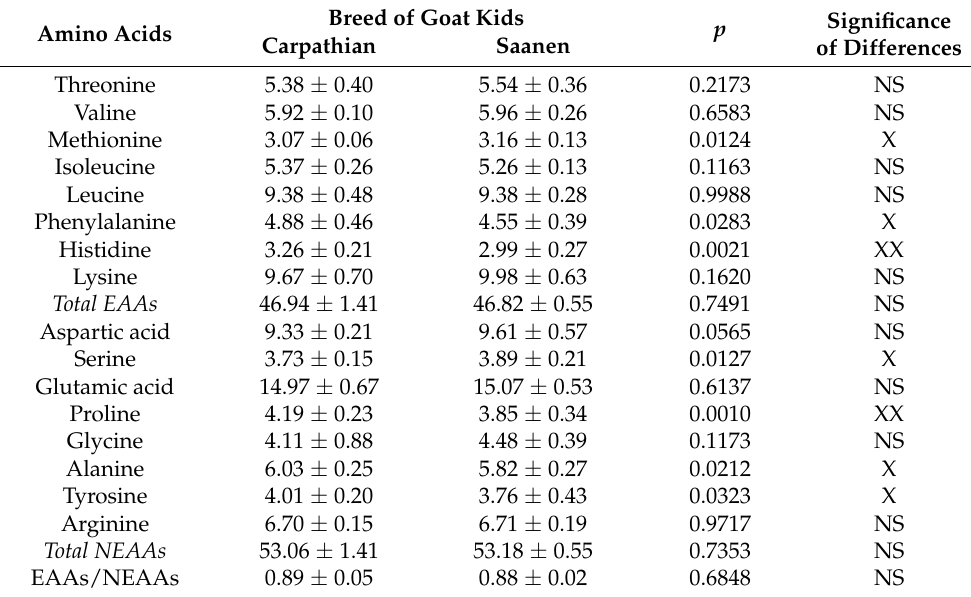
Table 5. Amino acid profile of protein in meat from male kid goats